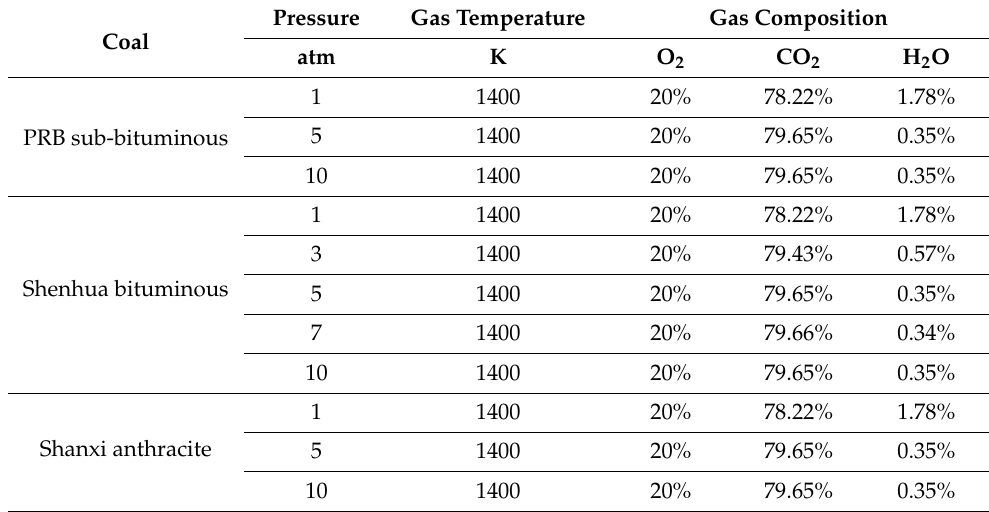
Table 1. Experimental conditions and gas compositions of the flue gas.